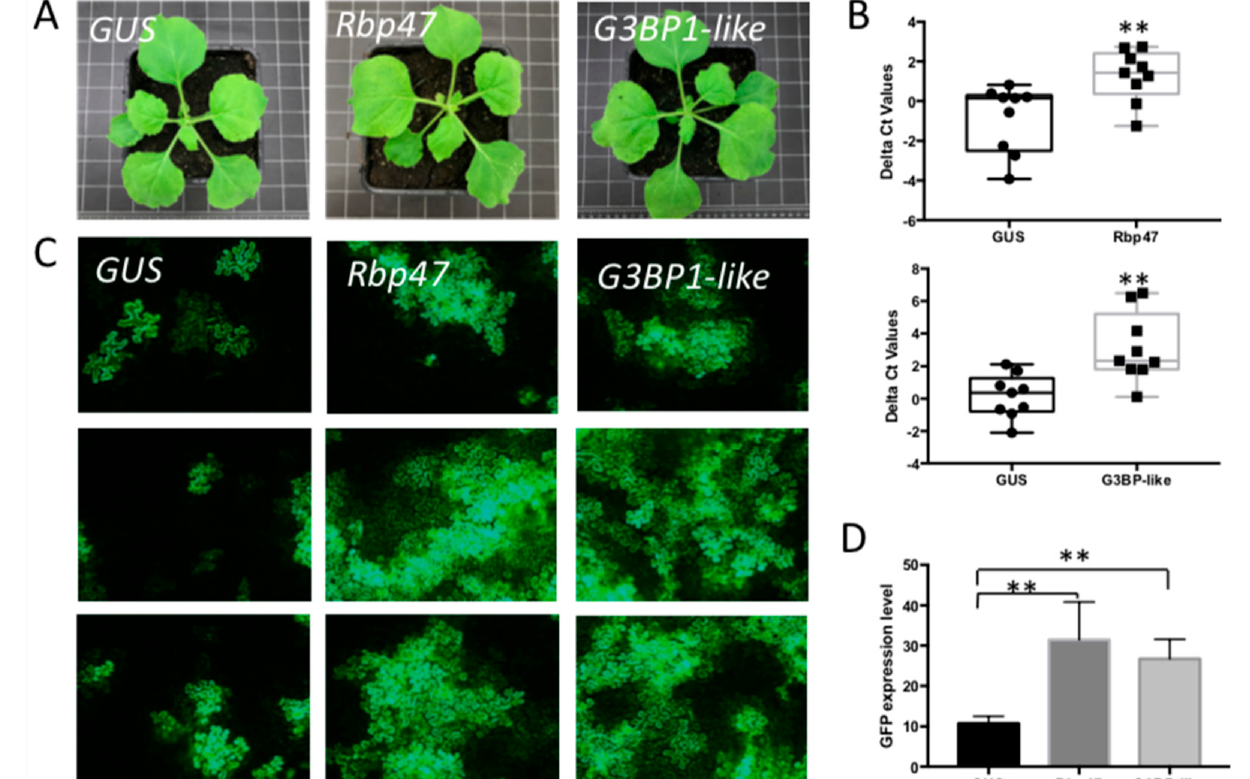
Figure 5. The effect of silencing SG assembly components on TSWV replication. ( A ) Plant phenotype after VIGS-silencing Rbp47 and G3BP1-like genes, compared with GUS -silenced control plant. ( B ) qRT-PCR assay to quantify the silencing efficiency. ** p -value < 0.01. ( C ) Green fluorescence result- ing from eGFP expression from a TSWV replicon in plants silenced on SG assembly components, and control plants. Plants were infiltrated with TSWV-eGFP replicon constructs 2.5-week post si- lencing and harvested at around 60 hpi. ( D ) Statistical analysis of GFP intensity in the silenced plants and control plants.